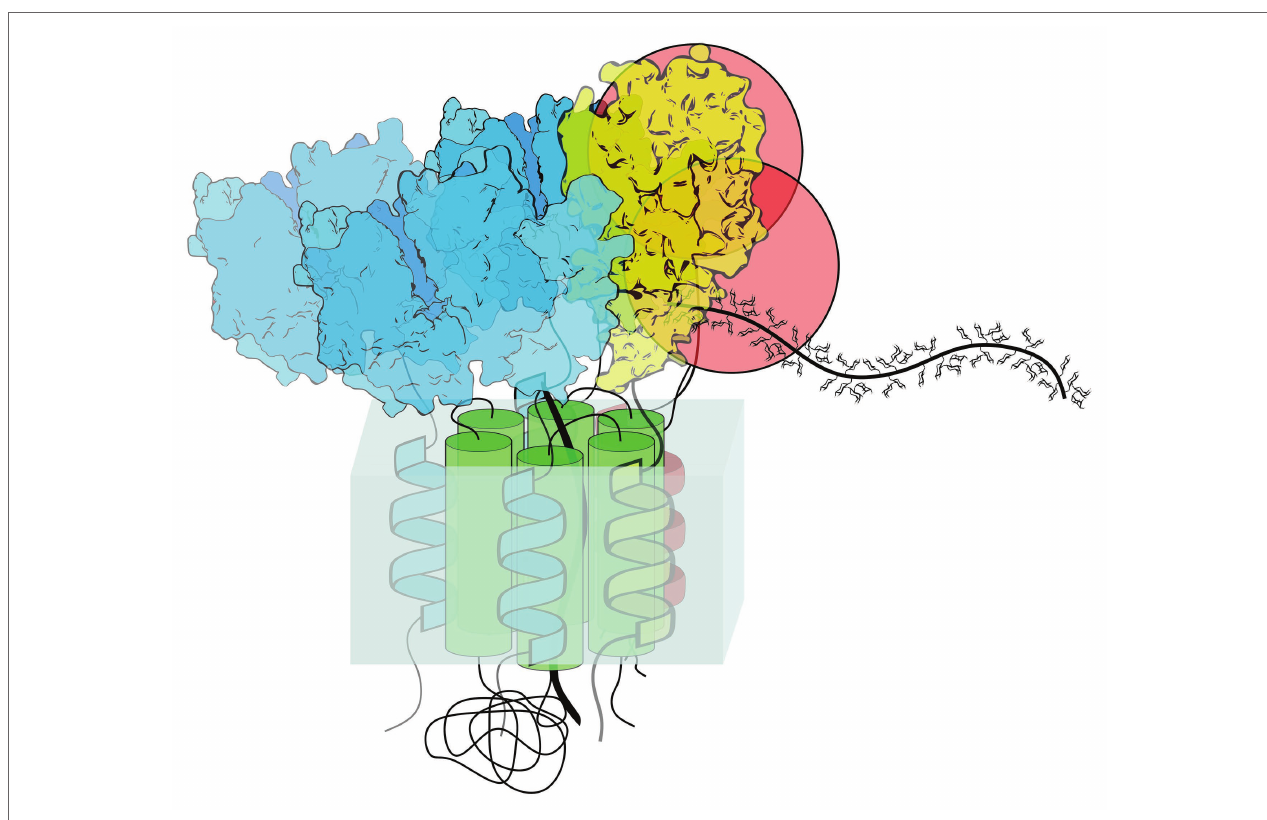
FIGURE 2 | Hypothetical organization of the xyloglucan synthesizing complex. Seven glycosyltransferases (GTs) have been shown to interact in the Arabidopsis Golgi, forming a multiprotein complex. It is hypothesized that GTs involved in the synthesis of xyloglucan side chains are organized around the CSLC protein that synthesizes the glucan backbone. The CSLC protein has a catalytic domain localized in the cytoplasm, where it adds glucose to the elongating glucan chain, moving the chain into the Golgi lumen through the pore formed by the six TMD helices (green). The other six GTs [three blue xylosyltransferases (XXT1, XXT2, and XXT5), two red galactosyltransferases (MUR3, XLT2), and yellow fucosyltransferase (FUT1)] interact with the TMD of the CSLC protein via their TMDs; in addition, the GTs interact with each other via catalytic domains. The actual crystal structures of XXT1, XXT2, XXT5, and FUT1 (Urbanowicz et al., 2017; Culbertson et al., 2018) are depicted here. Since the structures for MUR3 and XLT2 are not solved, these GTs are depicted as red